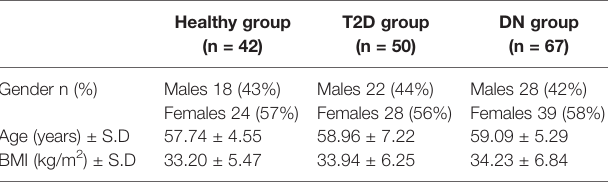
TABLE 1 | Demographic data of study